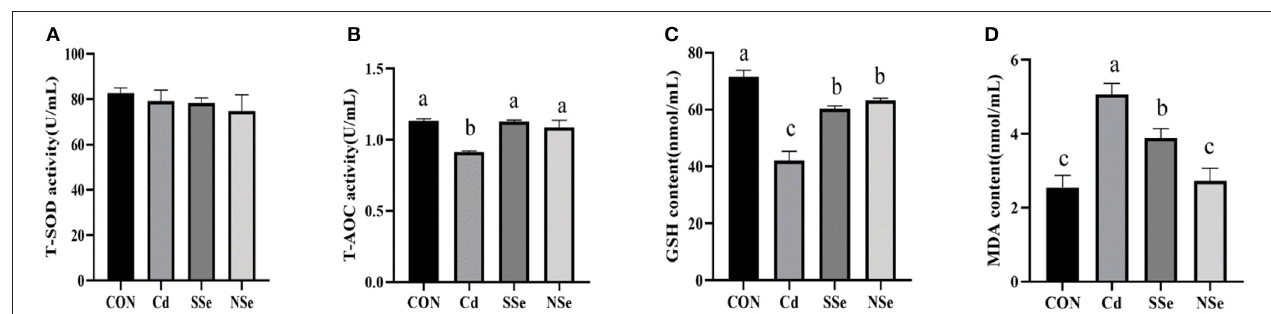
FIGURE 3 | Activities of antioxidant enzymes and concentrations of oxidative in serum. (A) T-SOD; (B) T-AOC; (C) GSH; (D) MDA. Different letters represent significant difference ( P < 0.05) within the column, and the same letters represent no significant difference ( P > 0.05).